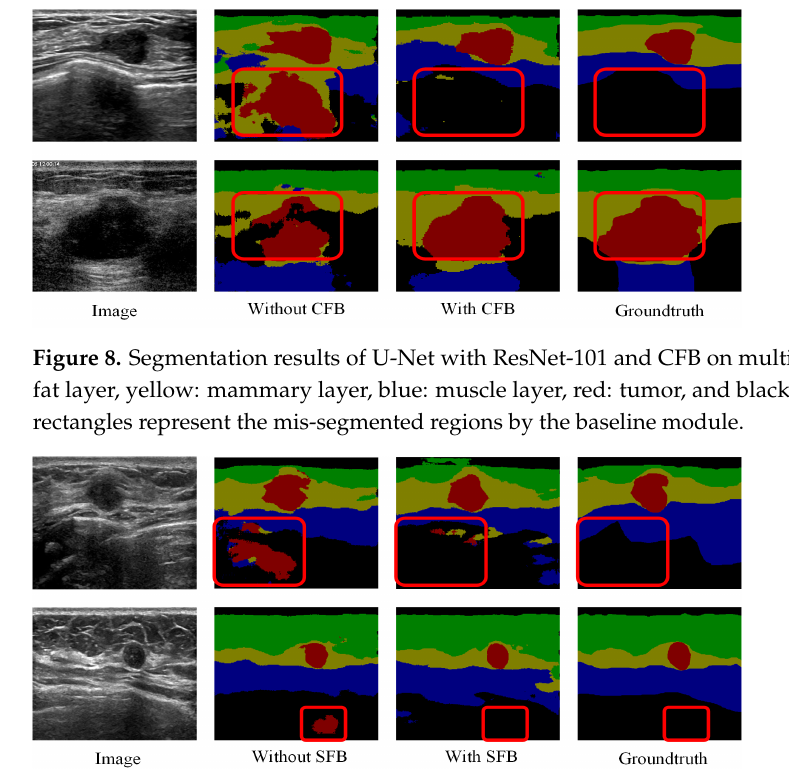
Figure 9. Segmentation results of U-Net with ResNet-101 and SFB on multi-object dataset. Green: fat layer, yellow: mammary layer, blue: muscle layer, red: tumor, and black: background. The red rectangles represent the mis-segmented regions by the baseline